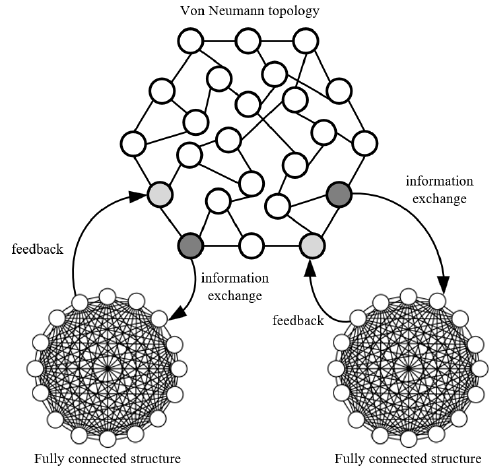
Figure 8. Schematic diagram of the parallel topology algorithm.